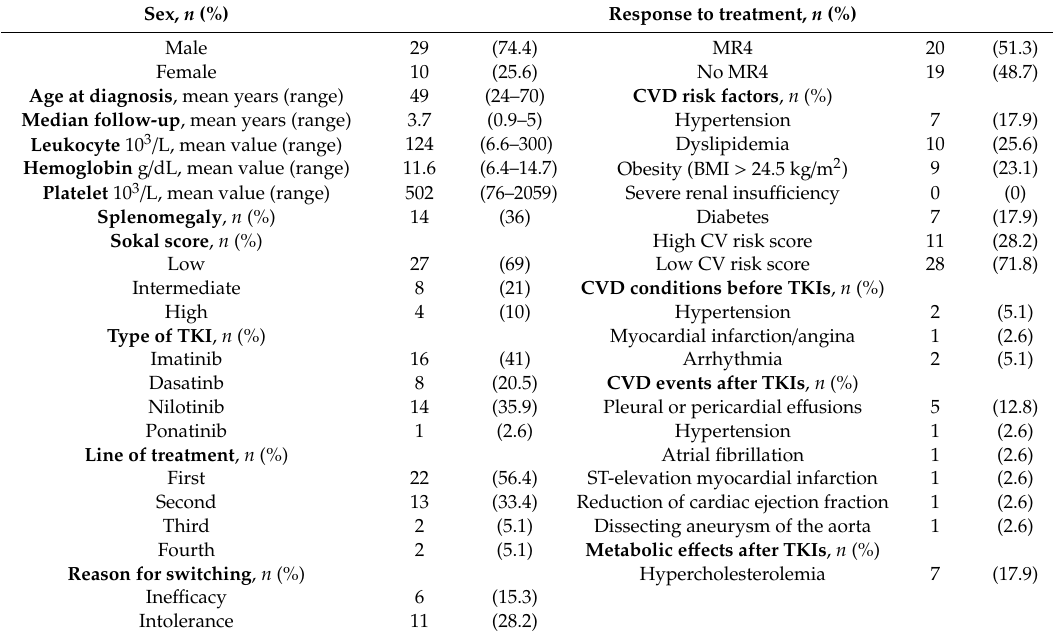
Table 1. Characteristics and cardiovascular profile of 39 patients with chronic myeloid leukemia. BMI, body mass index; CV, cardiovascular; CVD, cardiovascular disease; CV-AEs, cardiovascular adverse events; MR4, molecular response 4; TKIs, tyrosine kinase inhibitors.